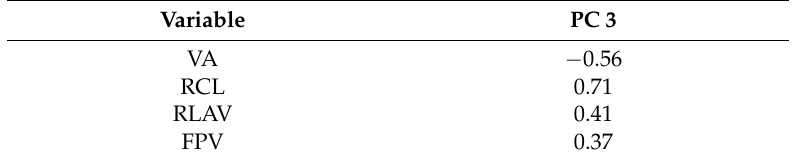
Table 7. Principal Components (PC3) and the anatomical structures of males of N . elegantalis .